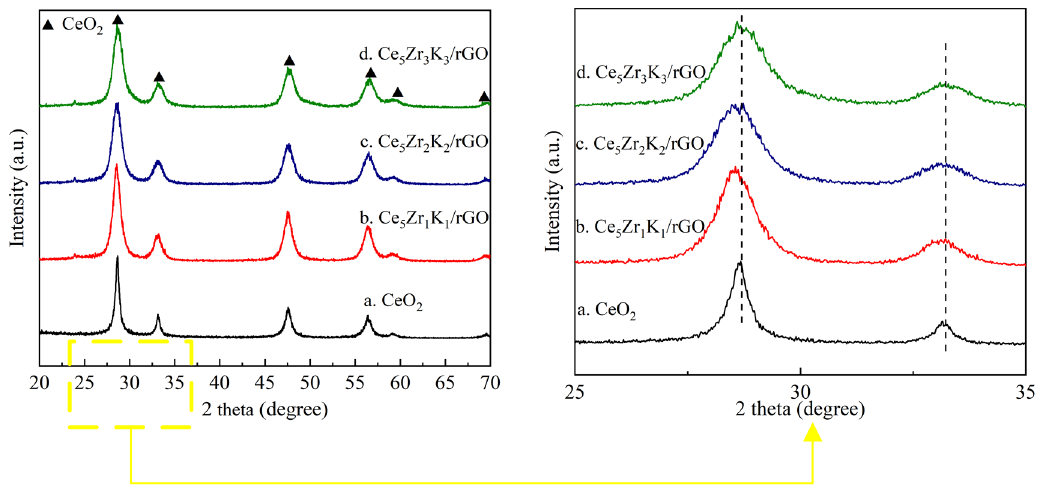
Figure 4. X-ray powder diffraction (XRD) patterns of CeO 2 and Ce 5 Zr 2 K 2 /rGO catalysts.